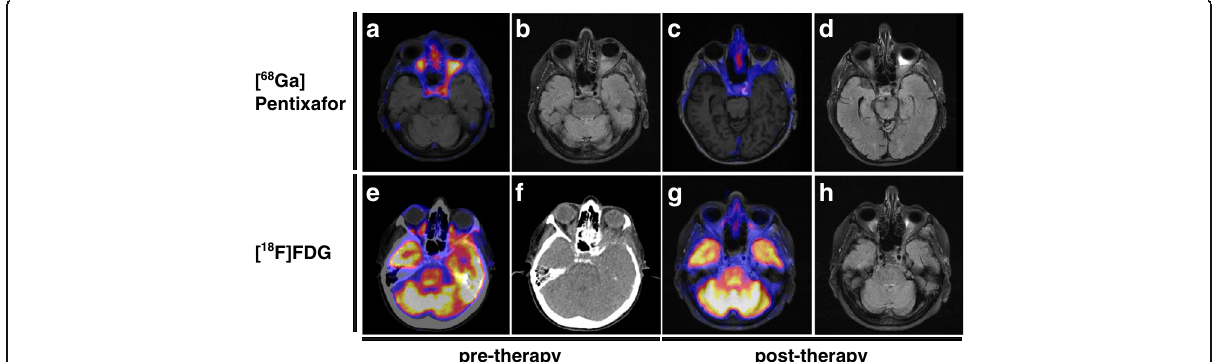
Fig. 2 Response assessment with CXCR4-directed PET imaging compared to standard [ 18 F]FDG PET. a , c , g PET/MR fusion. b , d , h MR imaging. e PET/CT fusion. f CT